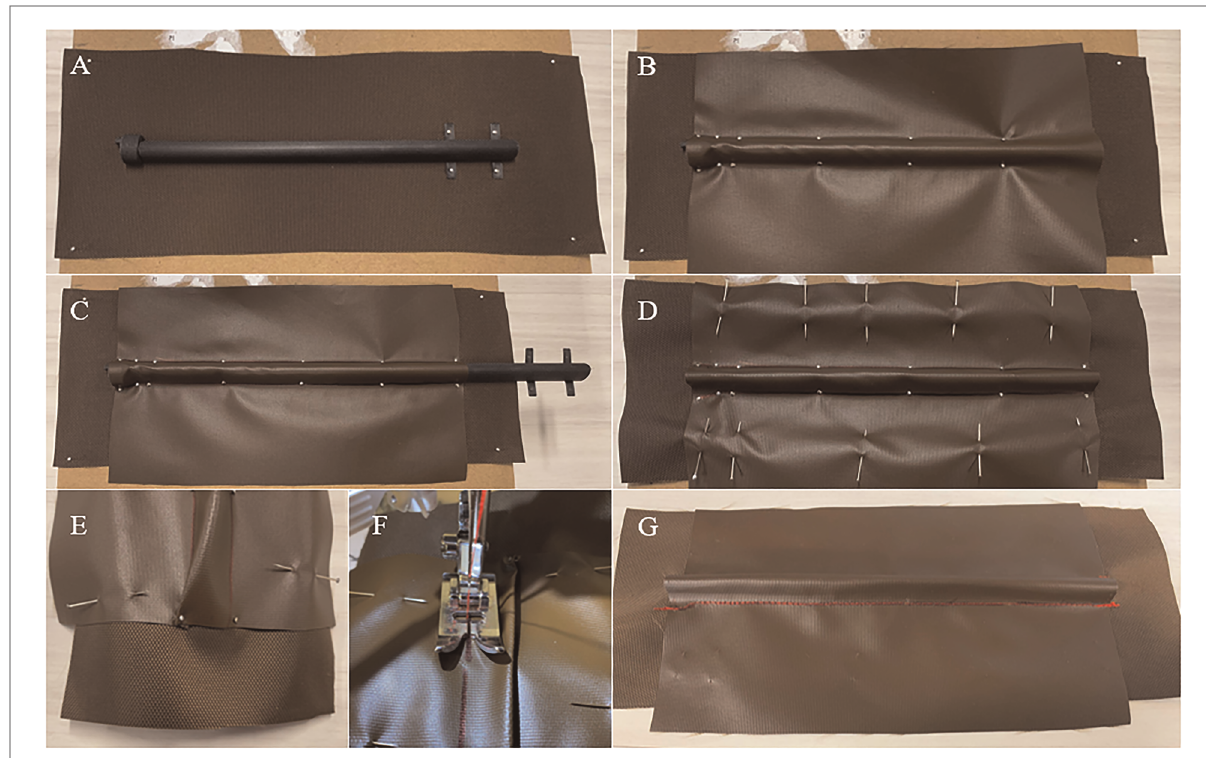
FIGURE 3 Channel fabrication procedure. First, the bottom and top layers are sized such that they are wider than the desired channel size to ensure that there is enough fabric to pin the material. The bottom layer is also sized longer than the desired length to simplify sewing. Then the following steps can be completed to create a channel: ( A ) The bottom layer and channel template are pinned in place to keep them from moving, and the inlet is placed at the end of the template. For simplicity, this is performed on a cardboard box to allow the pins to be pushed completely through the fabric. ( B ) The top layer of fabric is placed over the inlet and template, pulled taut, and pinned in place. ( C ) Before moving the template, the edge of the template is marked with pen as a guiding line for sewing. The template is slightly removed from the channel (to prevent it from getting trapped), and the end of the channel is pinned in place. ( D ) The two layers of fabric are pinned together to prevent them from slipping, and the channel is removed from the box. ( E ) To sew the channel, it must be fl at along the seam. The fabric can be pulled taut and pinned in place at the outlet to help hold the opposite seam fl at while starting to sew. ( F ) The seam is sewn along the guideline, while keeping the material pushed to the opposite side. ( G ) The previous two steps are repeated along the other side of the channel to obtain the fi nished